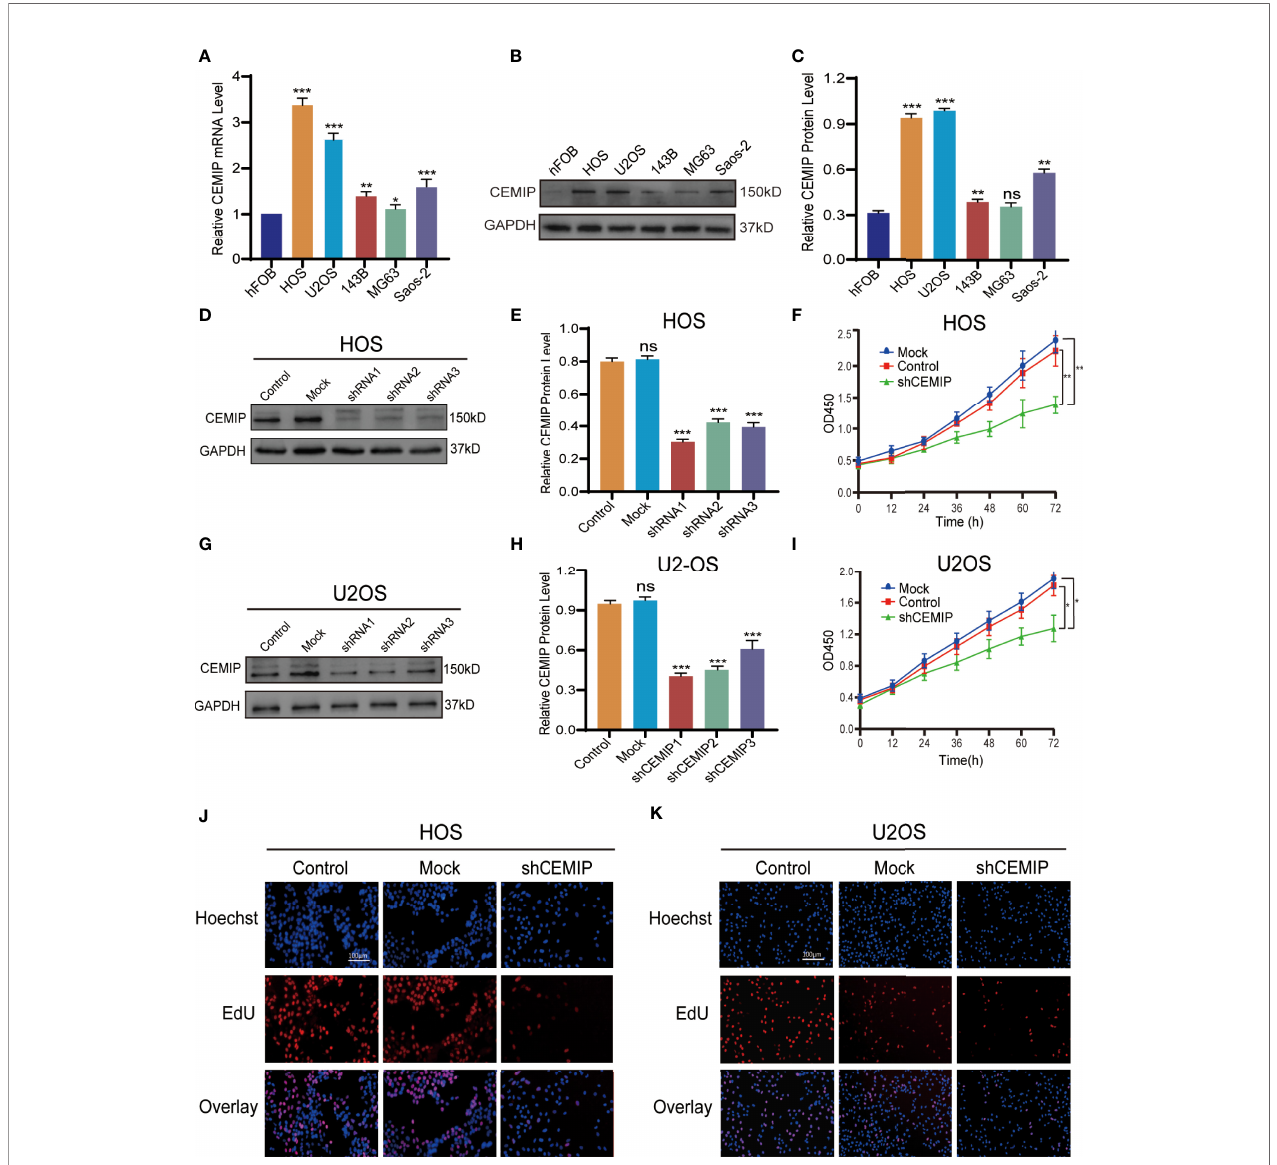
FIGURE 2 | CEMIP promotes the proliferation of osteosarcoma cells. (A) qRT-PCR analysis of CEMIP expression in hFOB and different osteosarcoma cell lines. (B, C) Western blot and its quantitative expression of CEMIP in hFOB and different osteosarcoma cell lines. (D, E) Western blot and its quantitative expression of silencing CEMIP in HOS cells. (G, H) Western blot and its quantitative expression of silencing CEMIP in U2OS cells. (F, I) The effect of silencing CEMIP on growth of HOS and U2OS cells were measured by CCK-8 assays. (J, K) The effect of silencing CEMIP on growth of HOS and U2OS cells were measured by EdU assays. * P < 0.05, ** P < 0.01, *** P < 0.001. ns, no signi fi